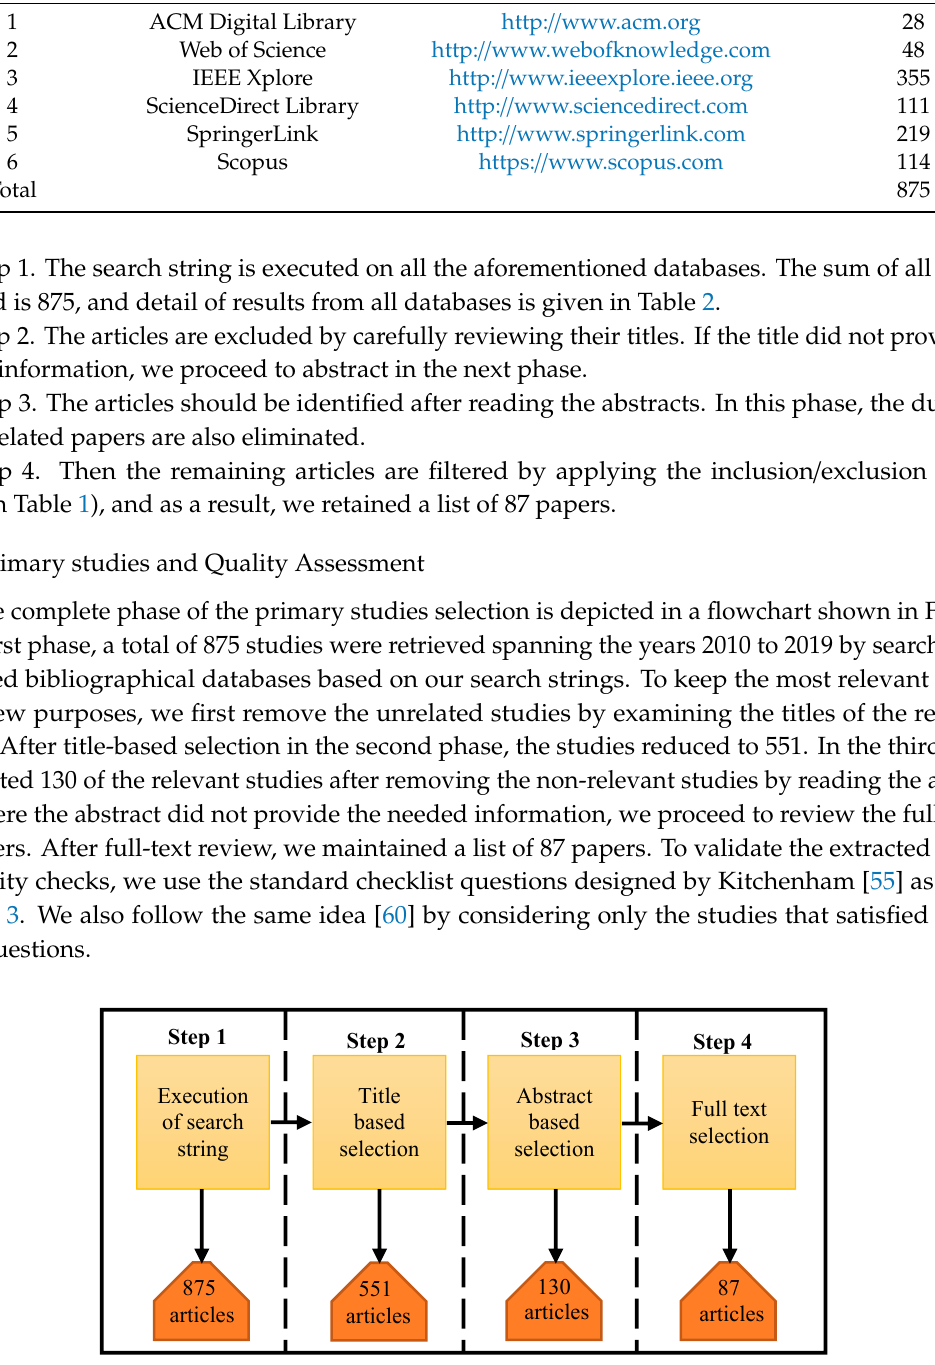
Figure 3. Steps of the selection process.